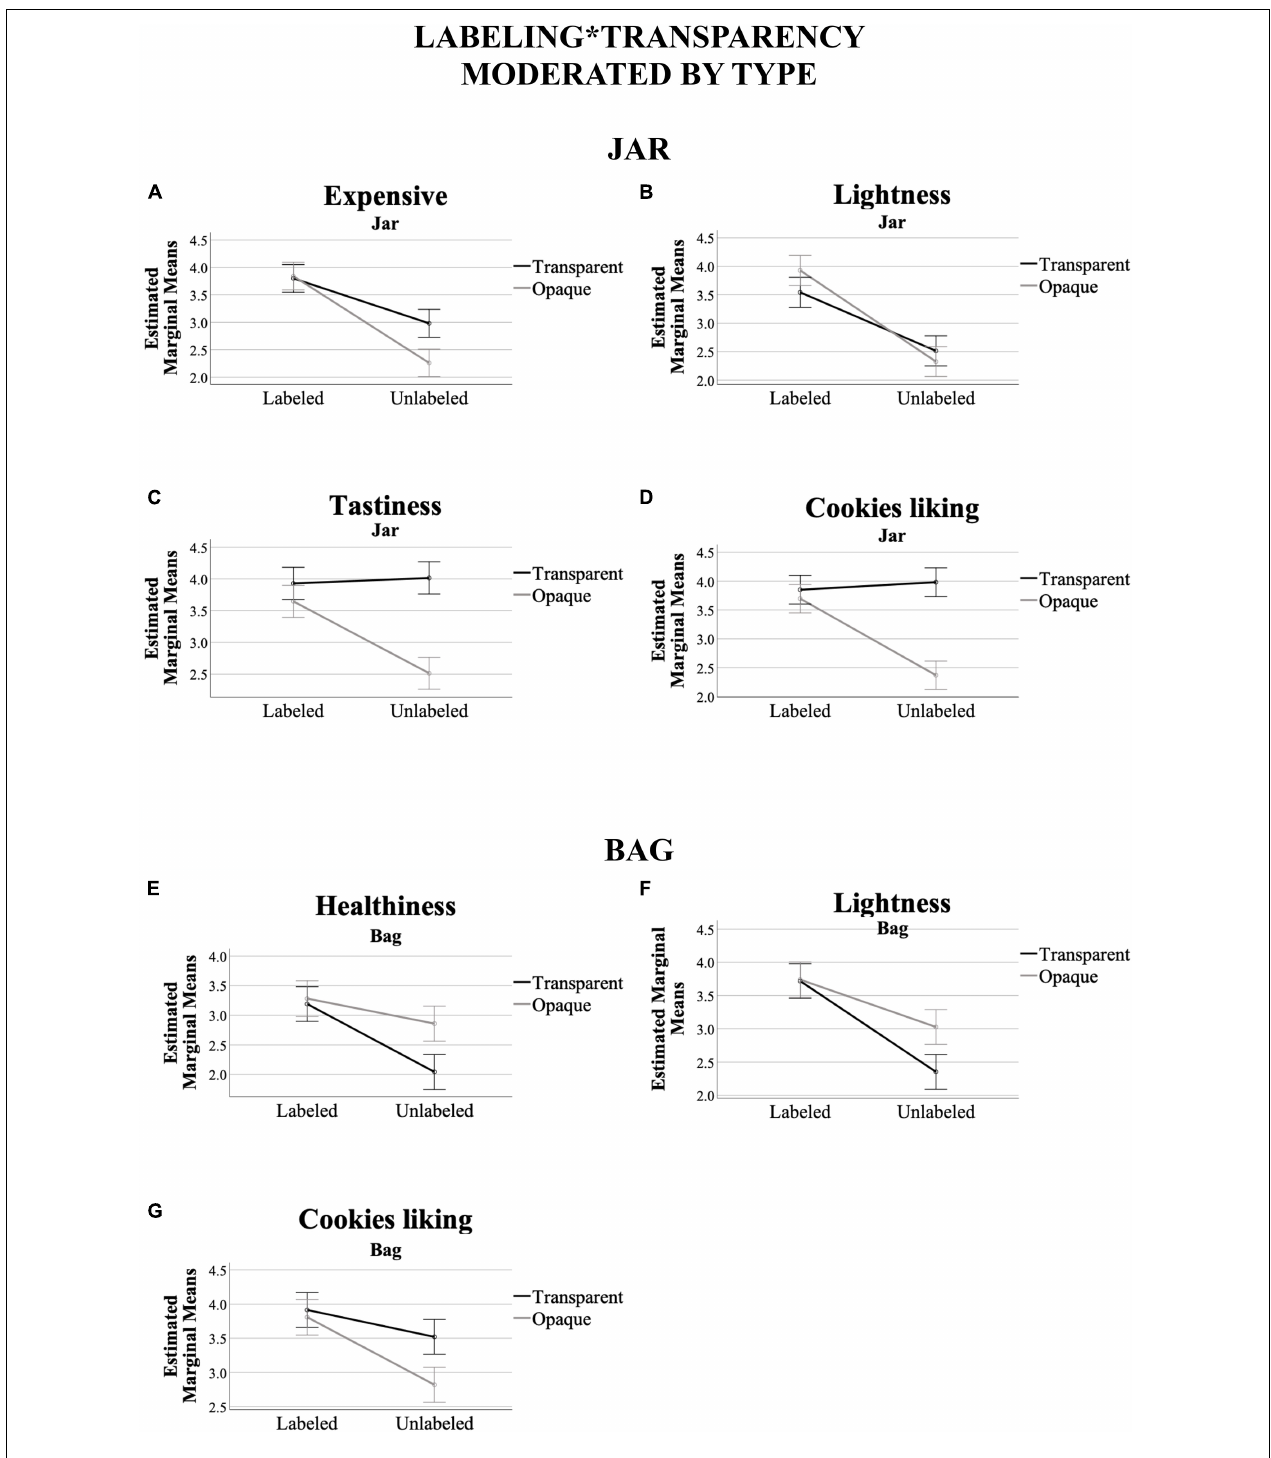
FIGURE 5 | Interaction effect of labeling*transparency, while moderated by type of packaging (jar vs. bag), across the variables that prompted significant differences at 95% confidence in “Moderating Effect of Type of Packaging on Labeling*Transparency” [for jar, (A) expensive, (B) lightness, (C) tastiness, (D) cookies liking ratings; for bag, (E) healthiness, (F) lightness, (G) cookies liking ratings]. Y -axis are the marginal means. X -axis are the labeling conditions. The black (darker) line corresponds to the transparent packaging ratings, whereas the gray (clearer) line the opaque ones. Error bars show confidence interval at 95%.